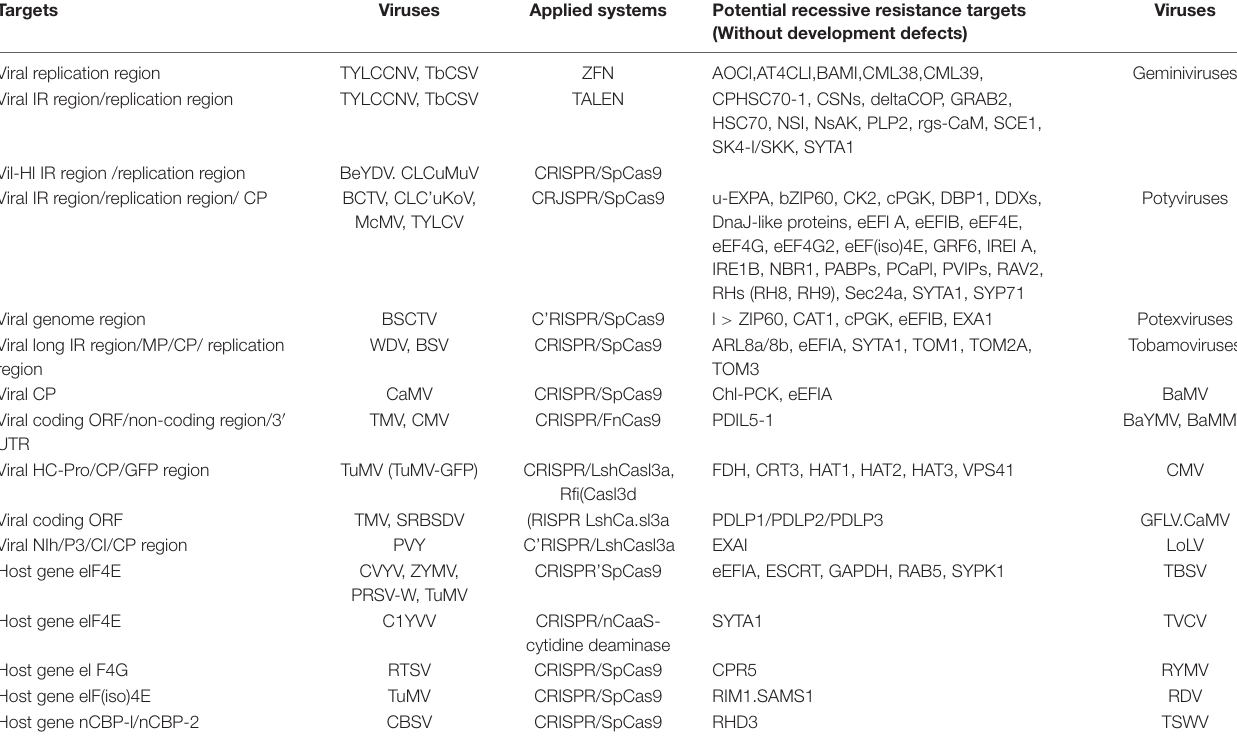
TABLE 1 | CRISPR/Cas system-mediated resistance to plant viruses by targeting the viral genome, host factors, and some potential recessive targets using genome editing systems. Targets Viruses Applied systems Potential recessive resistance targets (Without development defects)